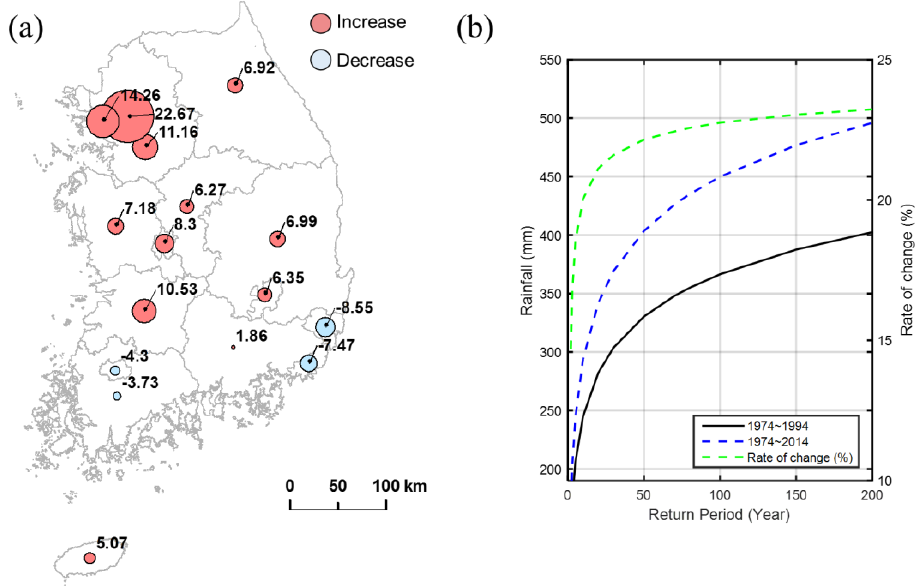
Figure 3. ( a ) Changes in the volume of 24-h rainfall with a 100-year return period; and ( b ) changes in the design rainfall for Seoul (Station 108) depending on various return periods.